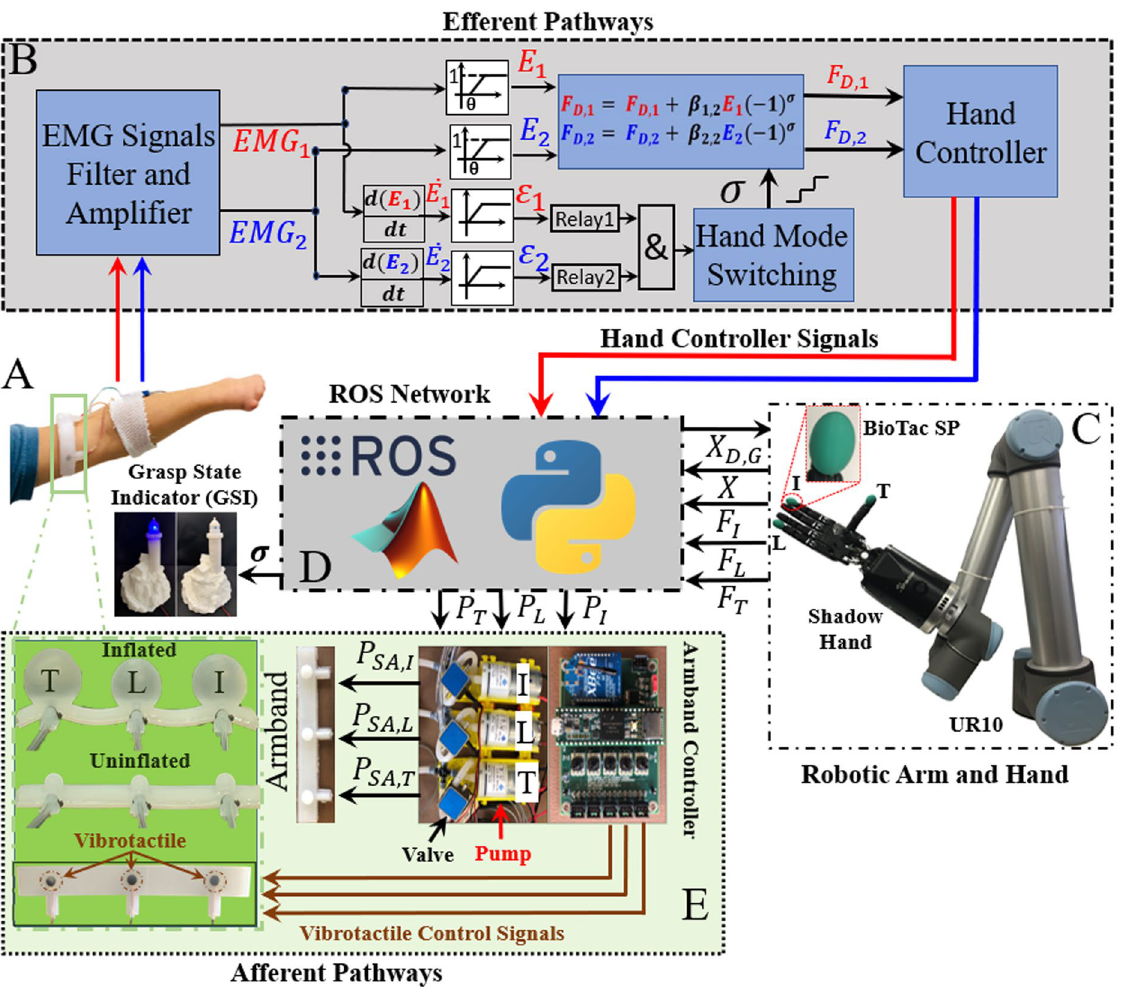
Figure 5. System Configuration: all the system components are interacting with each other through ROS, Python, and MATLAB/Simulink. ( A ) Two EMG surface electrodes were placed on the forearm of the human subject to record forearm muscle activities. The soft robotic armband was located on the upper arm. ( B ) EMG signal processing (Efferent Pathways) was done in Simulink to control the ( C ) Dexterous Shadow Hand and UR10 Robot arm that were interfaced via ( D ) ROS. ( E ) The soft robotic armband had a pump, valve, and pressure sensor for each of the three soft actuators. Vibrotactile actuators were also co-located with the soft actuators to give bimodal multichannel haptic feedback for both objects grasped simultaneously (Afferent